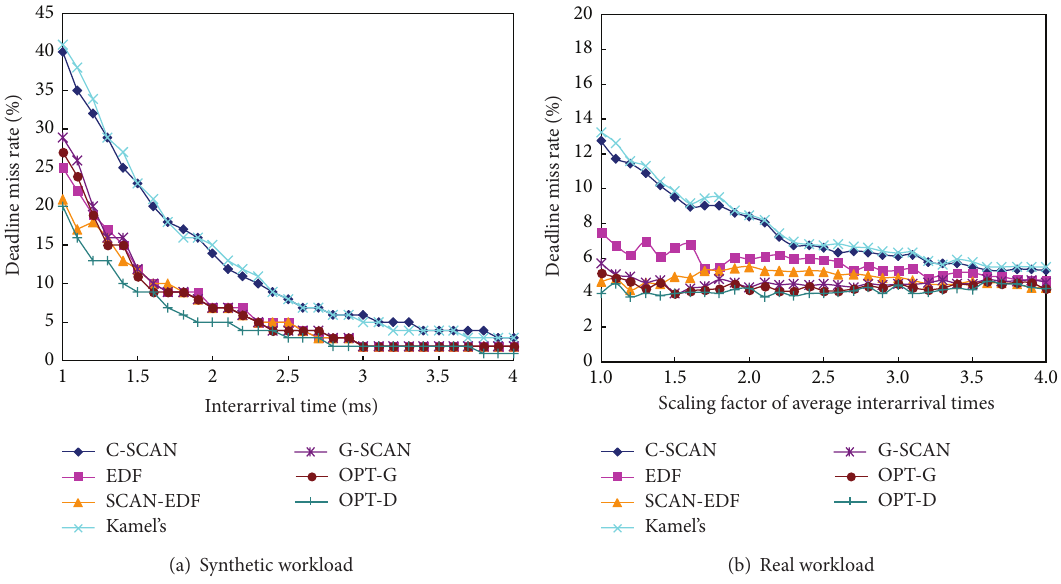
Figure 9: Deadline miss rate of the algorithms as a function of workload